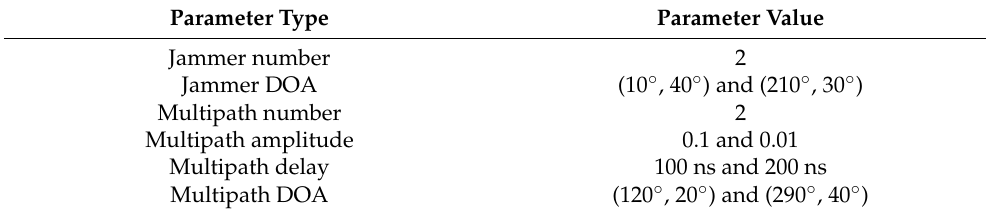
Table 6. Parameter